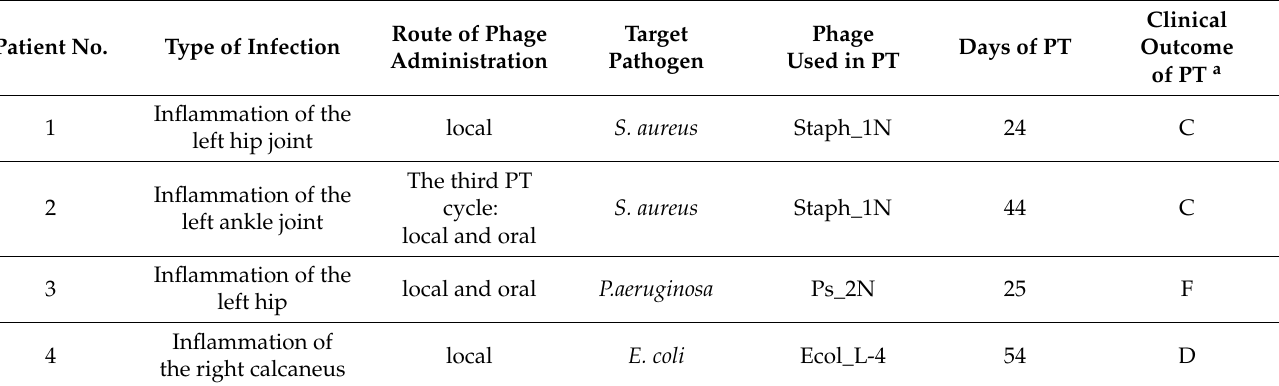
Table 1. Patients treated with